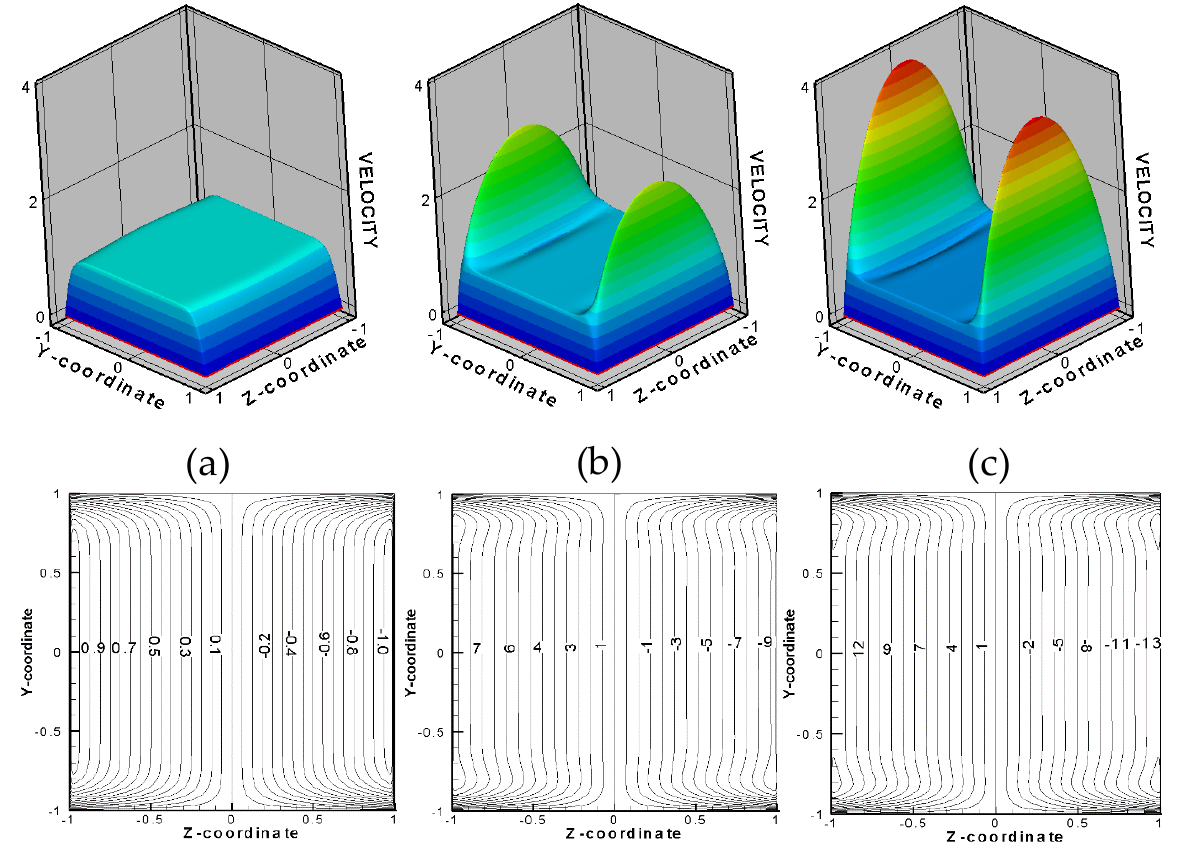
Figure 7. Velocity profiles ( top ) and induced magnetic field distributions ( bottom ) in the MHD flow in a square duct with electrically conducting Hartmann walls and non-conducting side walls (Hunt flow) at Ha = 200: ( a ) c w = 0, ( b ) c w = 0.05, and ( c ) c w = 0.1. The applied magnetic field is along the z axis.